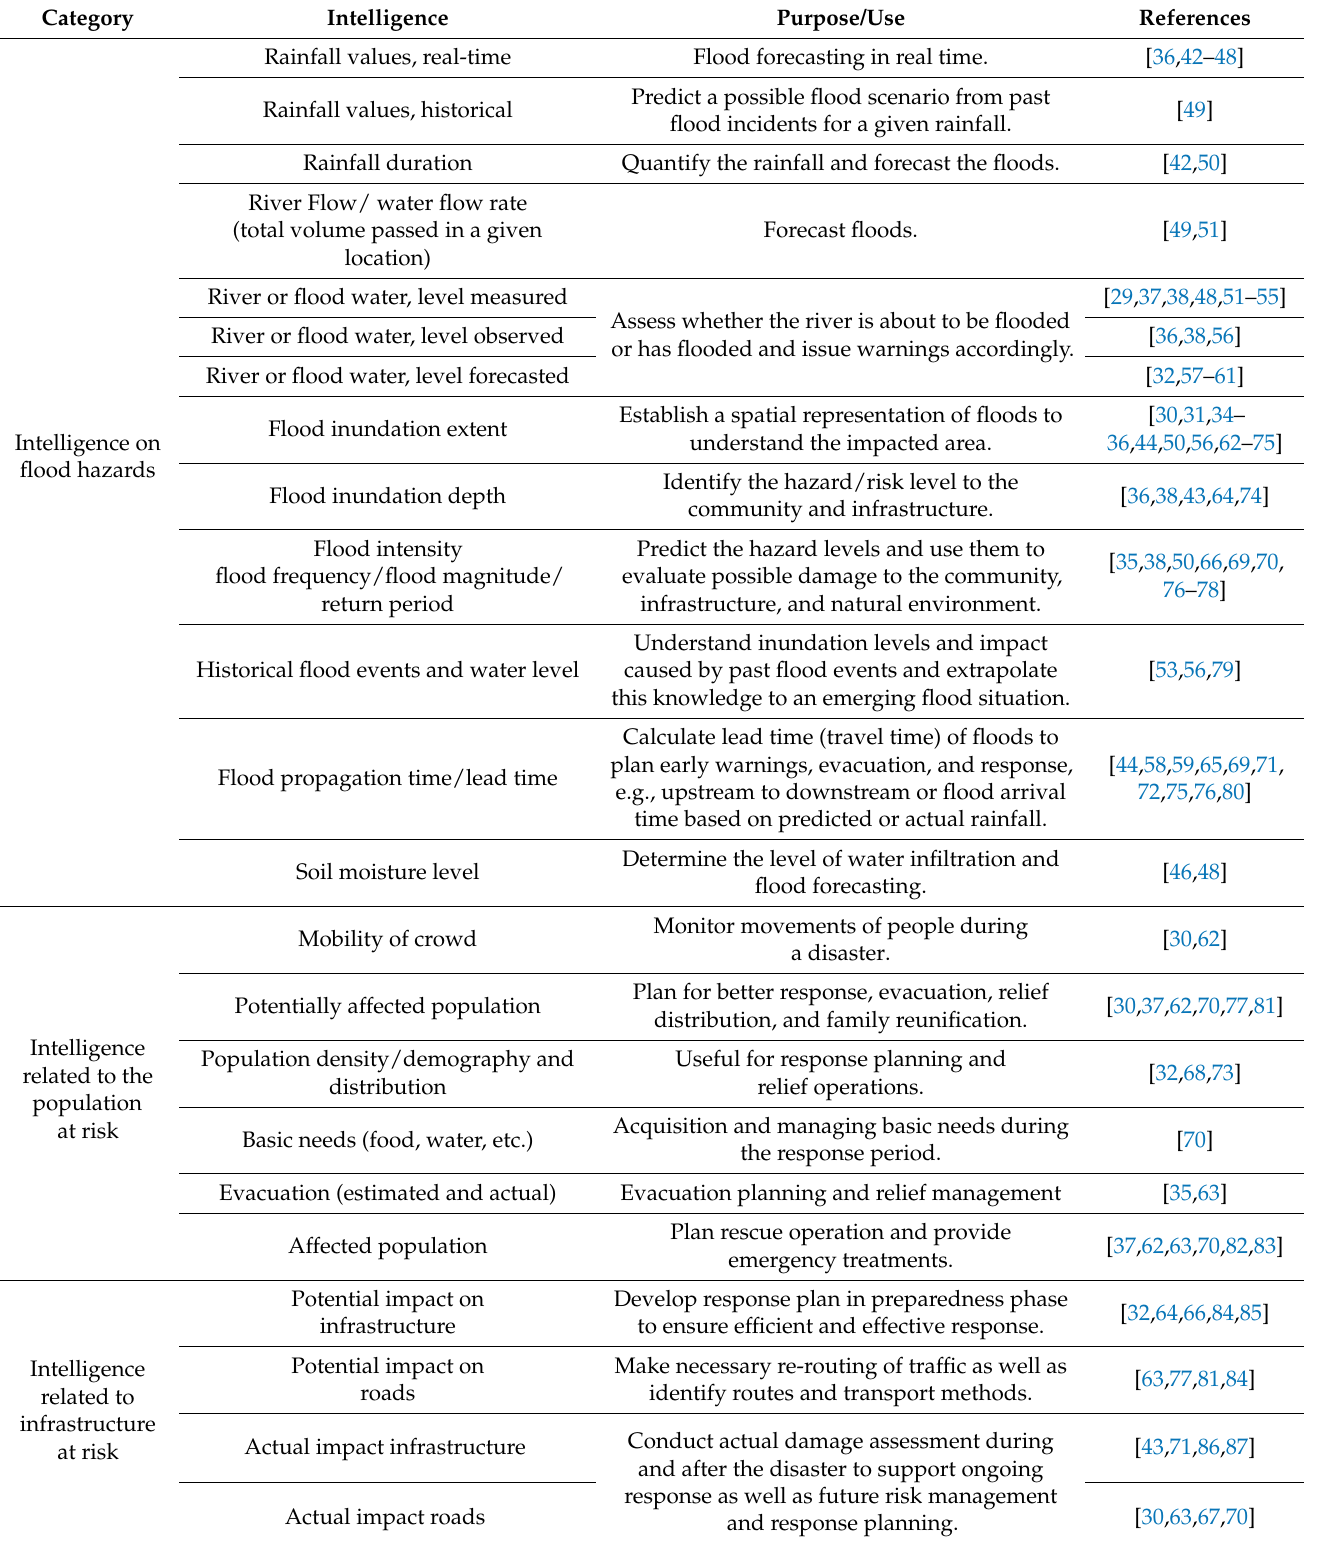
Table 1. Types of intelligence used in flood warning and response